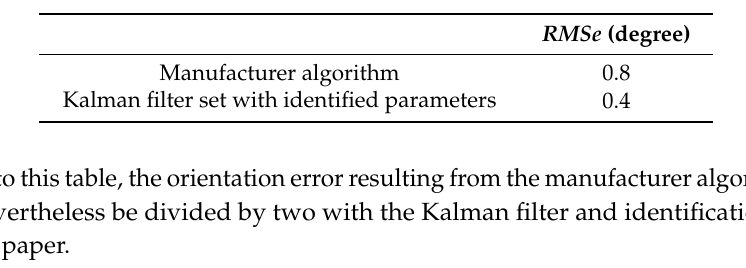
algorithm (b) with our Kalman filter set with the parameters identified with the methodology described in the paper. Table A2. Orientation error for slow intensity